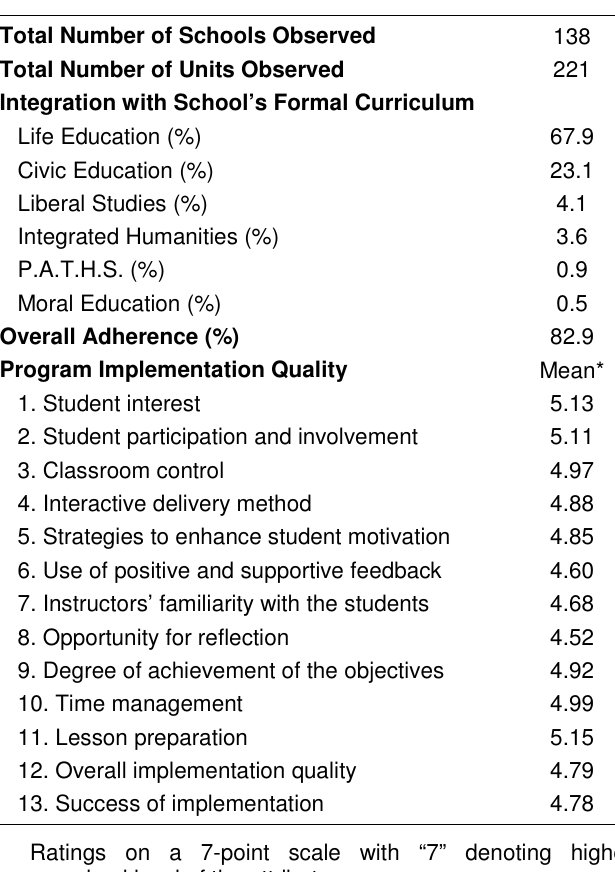
Summary of the Overall Ratings on the Units Observed in the Different